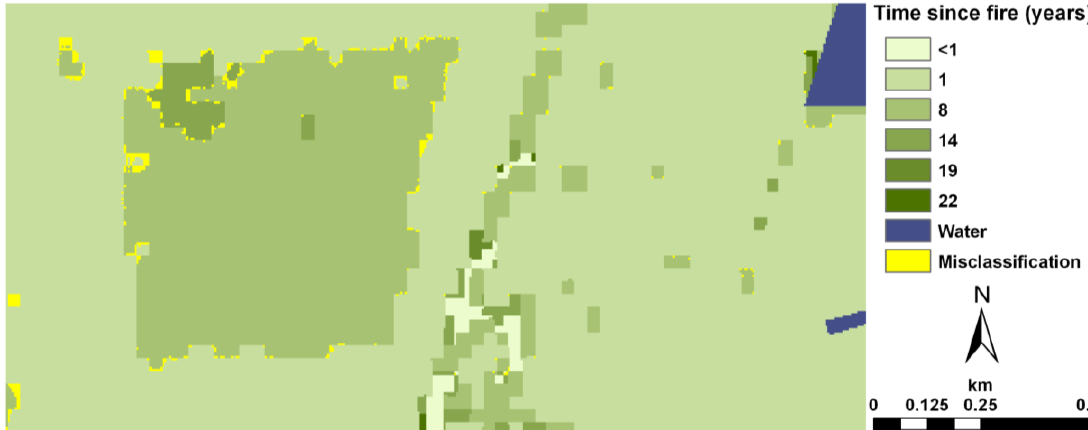
Figure 3. Results of SVM classification using a moving window size of 320 × 320 m and a cost parameter C = 7,000. Each cell in the map is 5 × 5 m in size. Green cells were classified with the correct time since fire (TSF), and the shade of green indicates the actual TSF value (see [25] for additional details on the TSF dataset). Yellow cells were misclassified, and blue cells denote reservoirs and surface water collection ponds within the study